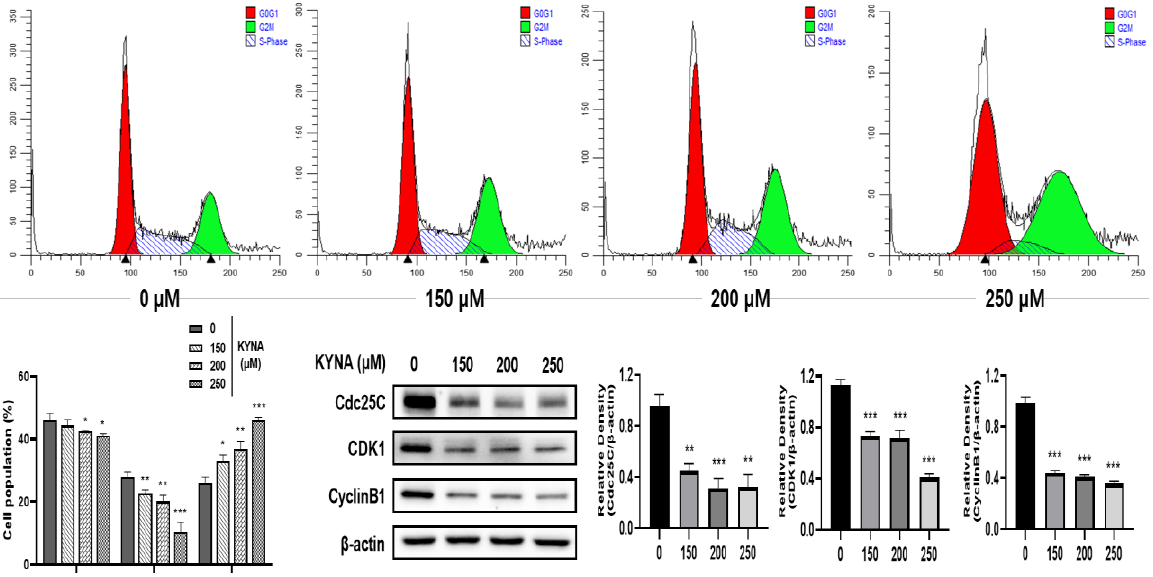
Figure 5. Effect of KYNA on cell cycle arrest of AGS cells. KYNA induces AGS cell G2/M cell cycle arrest. Cells were treated with KYNA (0, 150, 200, and 250 μM) for 24 h, and the cell cycle status was detected by flow cytometry. The results obtained from three independent experiments were expressed as mean ± standard deviation (SD) compared with the control group. * p < 0.05, ** p < 0.01, *** p < 0.001.